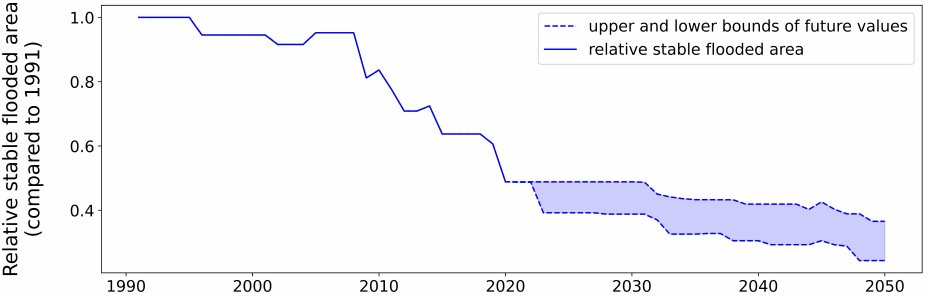
Figure 15. Retrospective (1991–2021) and forecast (2022–2050) dynamics of the area of stable flooded territory in the interfluve.